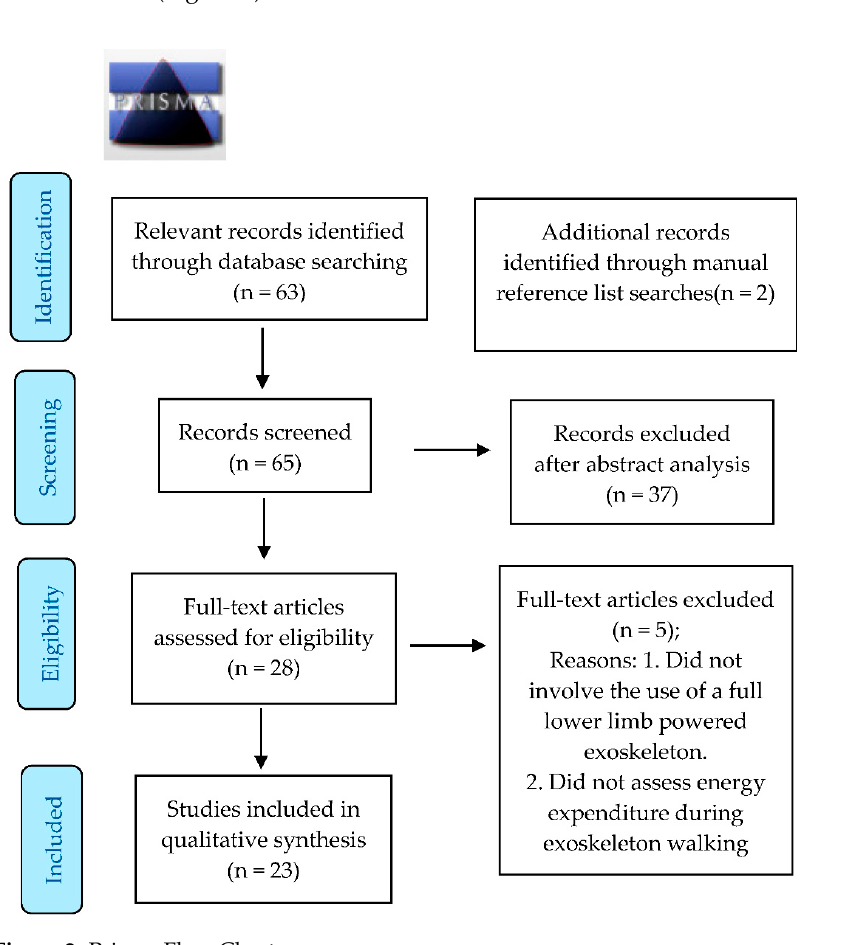
Figure 2. Prisma Flow Chart.